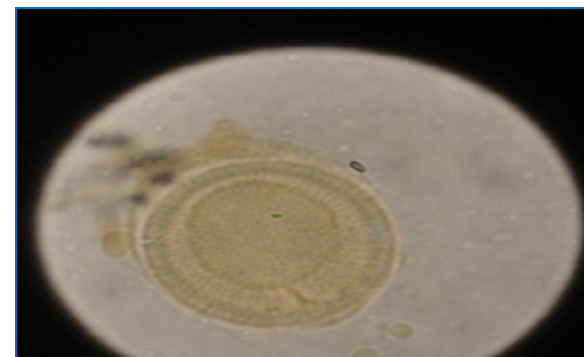
Figure, e: Taenia sp. egg in stray dogs.